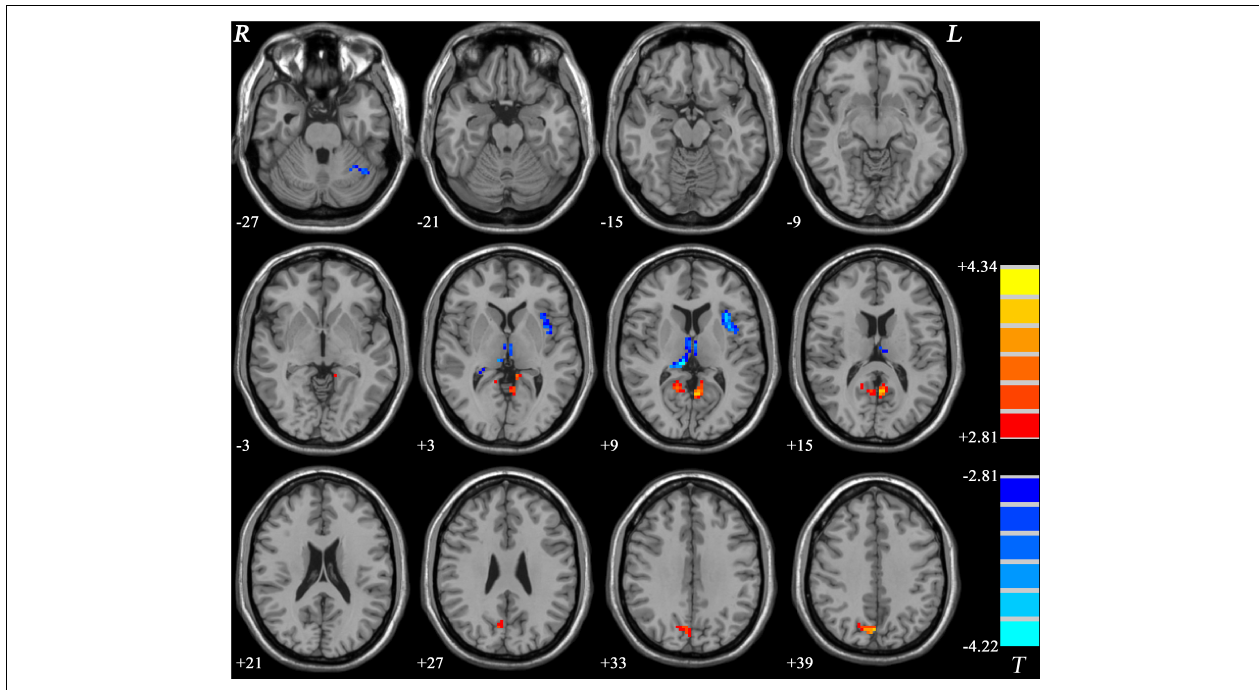
FIGURE 3 | Regions with significantly different PAS scores in GI-MDD patients compared to HCs. The color bar indicates the T -values from post hoc t -tests. GI-MDD, major depressive disorder with gastrointestinal symptoms; HCs, healthy controls; PAS, parameter of asymmetry.